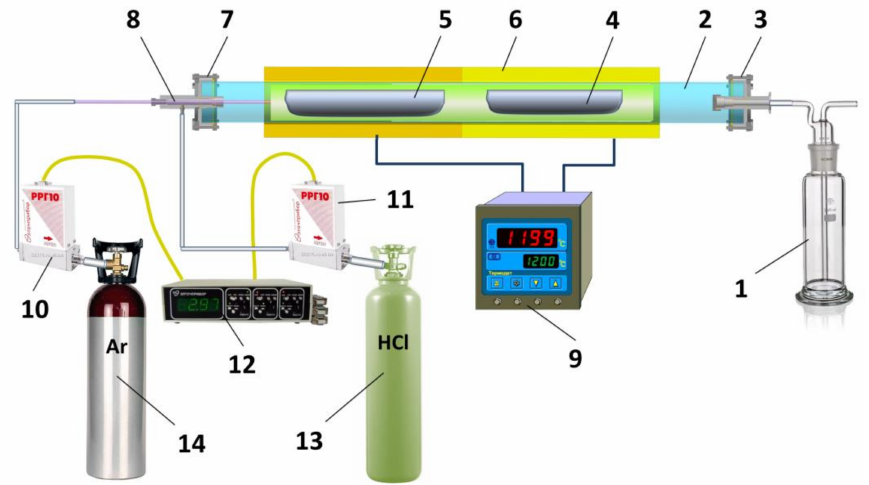
Figure 4. Setup for chlorination of powder preparations: 1—Drexel vessel; 2—quartz-glass reactor valve; 3—outlet pipe system with fungal seal; 4—glassy carbon container for GdCl 3 ; 5—glassy carbon container for NH 4 Cl; 6—double zone resistive furnace with cerablanket thermoinsulation; 7—inlet pipe system with fungal seal; 8—capillary tube connector for gas inject; 9—dual channel temperature controller; 10 and 11—mass flow controller; 12—control block for mass flow controllers; 13—HCl cylinder; 14—argon cylinder.